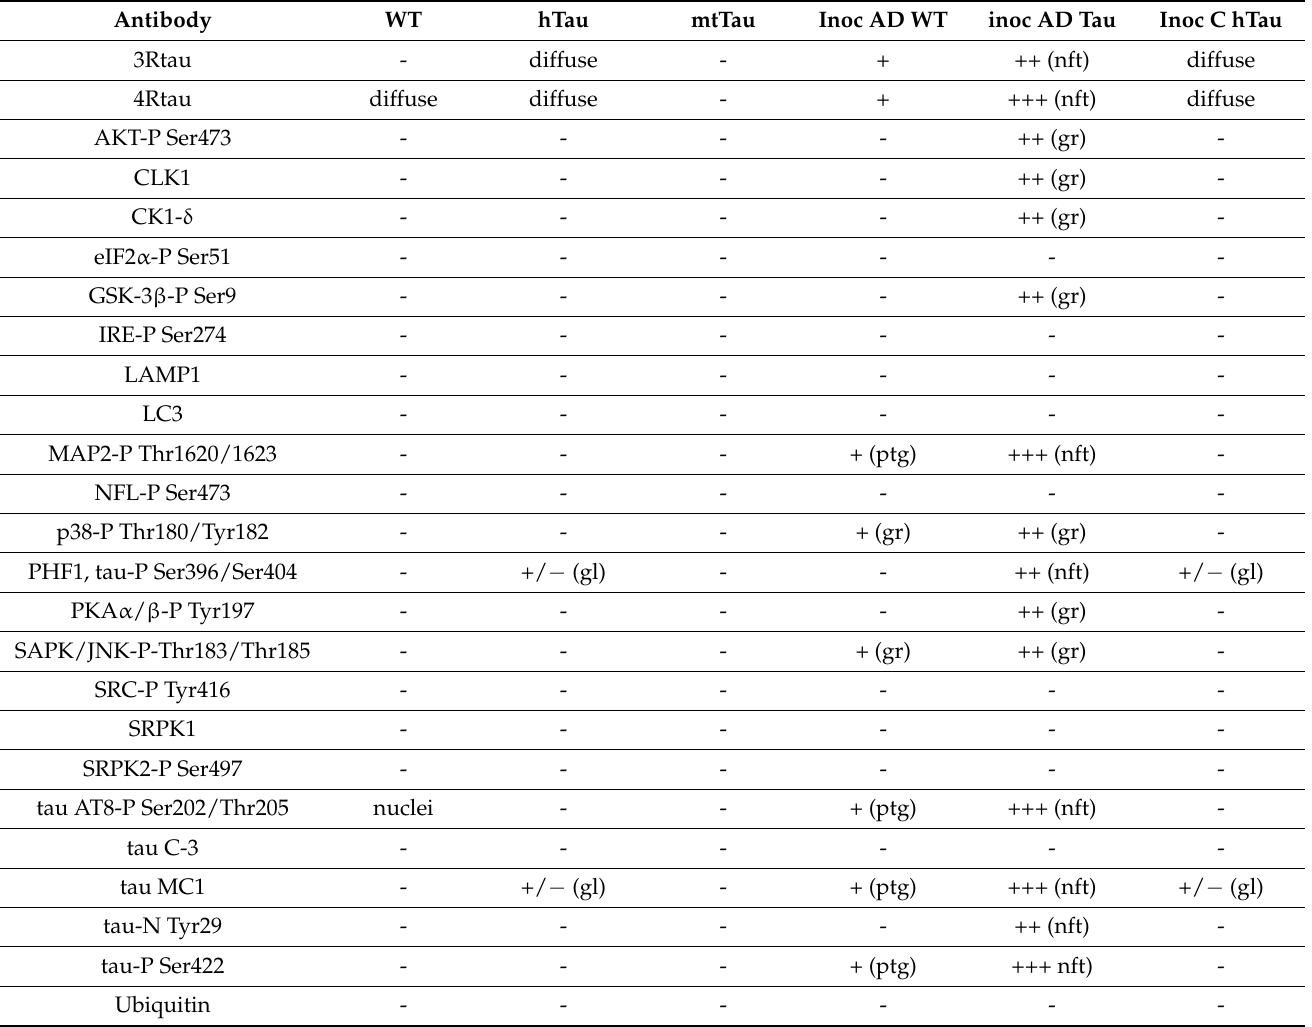
Table 1. Characteristics of tau deposits in neurons of the hippocampus and dentate gyrus in non- inoculated WT, hTau, and mtWT mice; WT, and hTau mice unilaterally inoculated into the hippocam- pus with the same AD inocula (inoc AD WT, and inoc AD tau, respectively); and inoculated